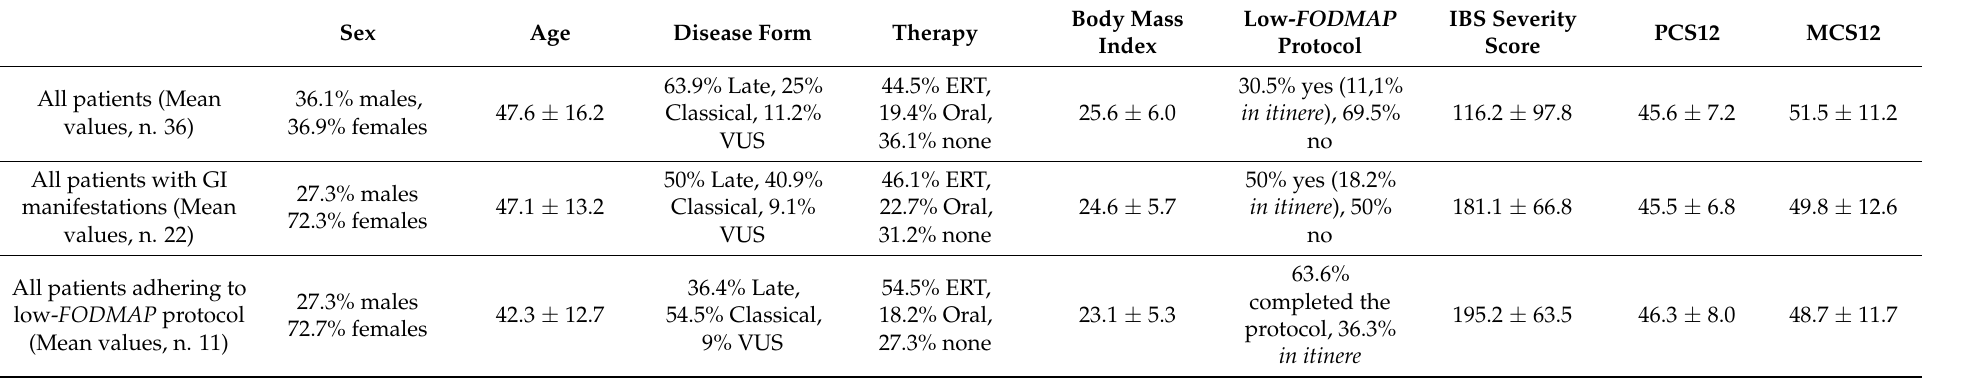
Table 2. General characteristics of all patients (n. 36), patients with GI manifestation (IBS severity score >75, n. 22), patients adhering to the low- FODMAP protocol (n. 11): sex (males, females); age (years); disease form (classical, late, or variant of uncertain significance (VUS)); therapy at the first evaluation (oral, ERT, or no